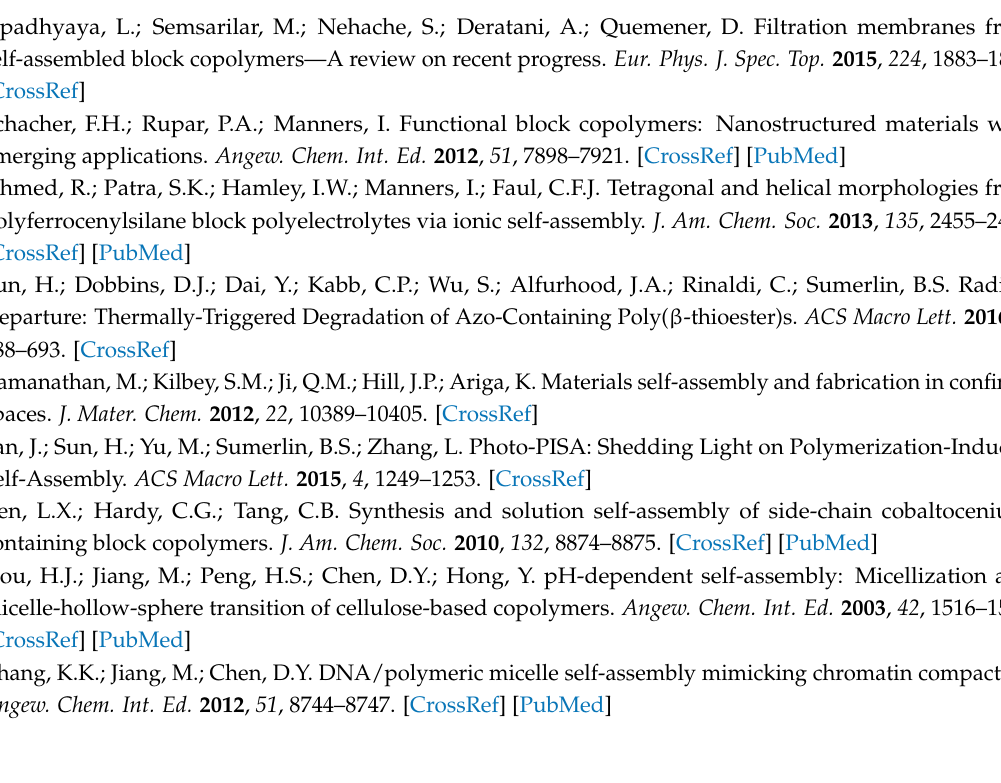
Table S1: PS 10K -PNaSS 10K -PS 10K solution composition and film characteristic; Figure S1: AFM images of the film prepared with PS (b) Cross-sectional profile of the topography along the line shown in image (a) (c) 3D view of the AFM topography image; Figure S3: (a) Topography AFM image of PS 10K -PNaSS 10K -PS 10K after spin coating (b) FFT of image (a) (c) Mathematic treatment of the FFT, obtained by circular mean, of topography image (a); Figure S4: Illustration of the L c on the AFM topography image. Lc represents the size of one spherical micelle; Figure S5: (a) SEM image of PS 10K -PNaSS 10K -PS 10K after drying by spin coating and detachment from the wafer by immersion in water (b) image (a) binarized using Matlab software (c) Diagram of Normalized intensity of the pixels versus pixel obtained by the data treatment on image (b) using Matlab software; Figure S6: SEM images of the virgin Nylon membrane used as support for the coating of PS 10K -PNaSS 10K -PS 10K (a) Top surface (b) Zoom of the top surface (c) Bottom surface (d) Cross-section of the uncoated membrane; Figure S7: AFM 3D view and profile of the coated membrane after filtration cycles under pressure; Figure S8 : Zeta potential curve versus pH for the uncoated commercial Nylon membrane; Figure S9 : Zeta potential curve versus pH for the uncoated commercial Nylon